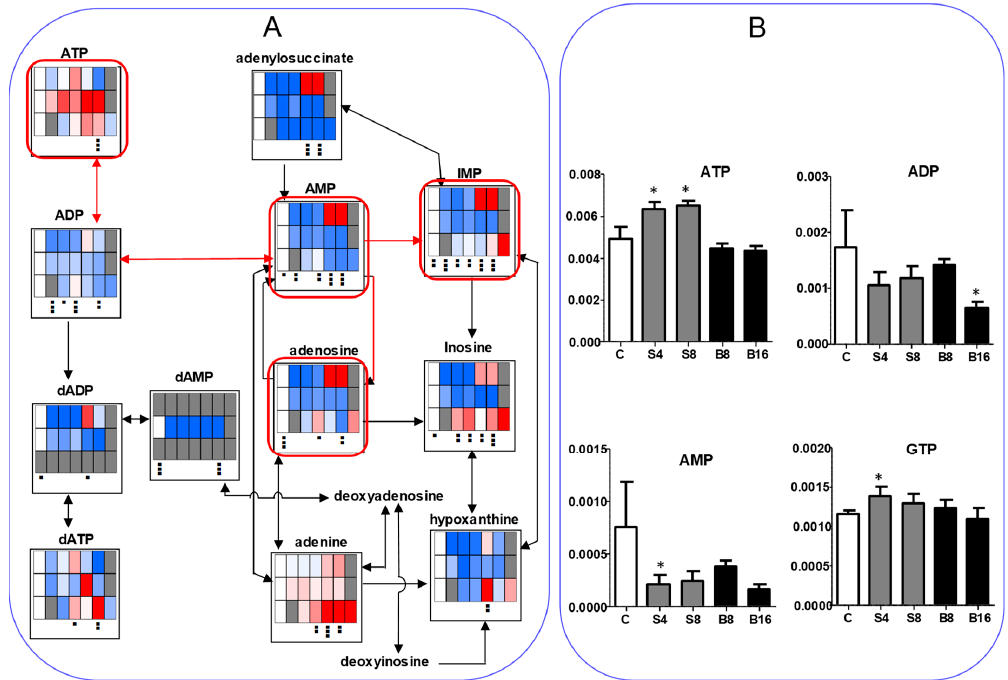
Figure 7. BA as well as SBA, but not, SA, reduce the ATP utilization. ( A ). SBA (60 min), BA (90 min), SA (30 min). HSC-2 cells were treated as Exp. I in Materials and Methods. ( B ). Horizontal axis from left to right: C, S4, S8, B8, and B16 represent control, 4 and 8 mM SBA, 8 and 16 mM BA, respectively. HSC-2 cells were treated as Exp. II in Materials and Methods. Vertical axis, μ mol/cell. Each value represents mean ± S.D. ( n = 3). The procedures used to produce heat maps and statistical analyses were described in the legend of Figure 5. * p < 0.05.